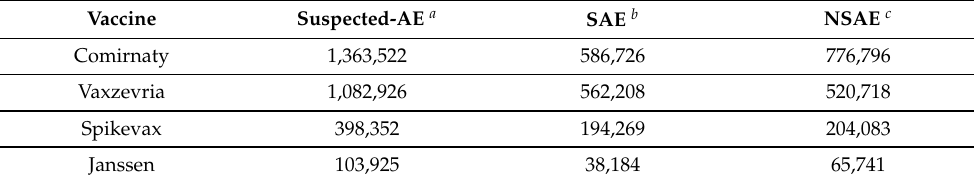
Table 10. Comparative analysis of vaccines by seriousness of the reported adverse